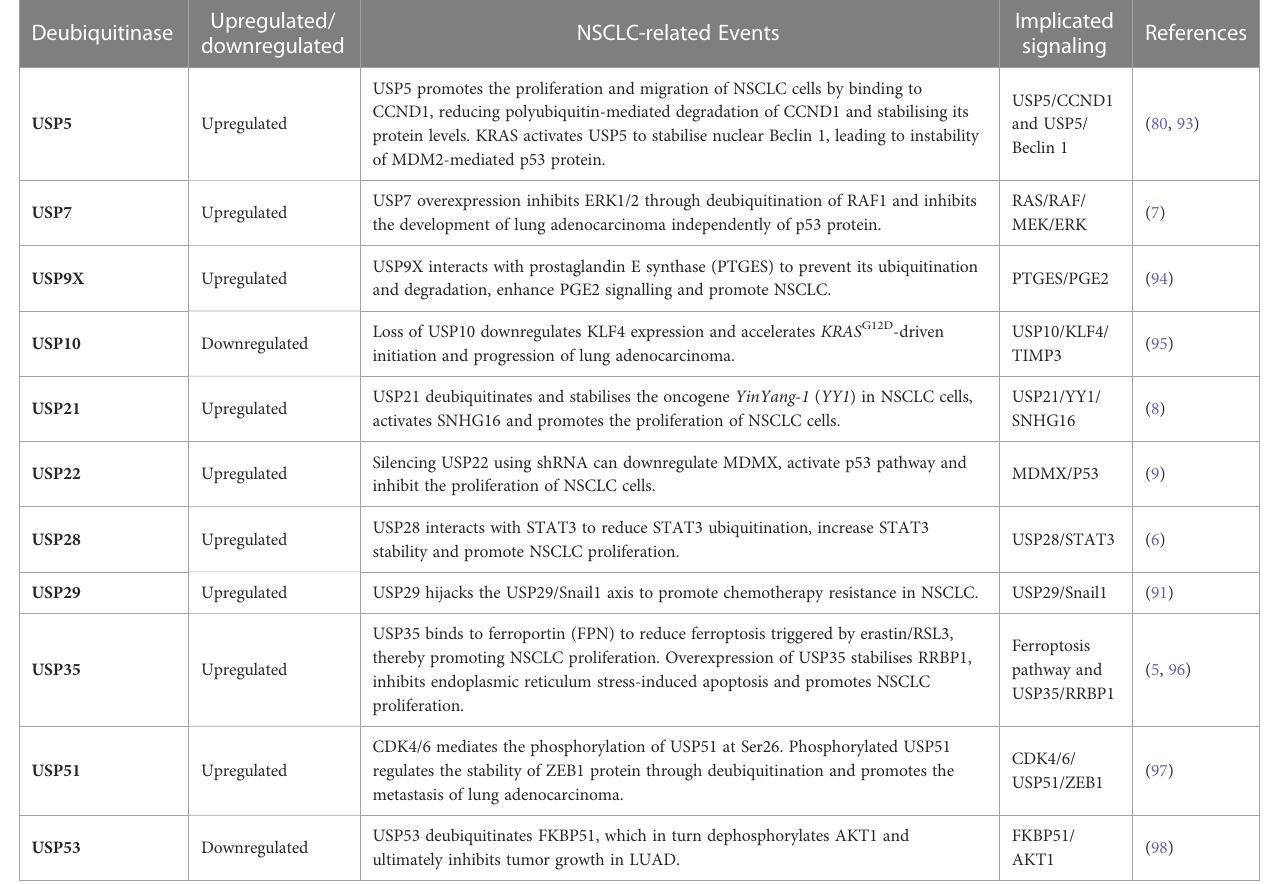
TABLE 1 Ubiquitin-speci fi c proteases upregulated/downregulated in NSCLC.